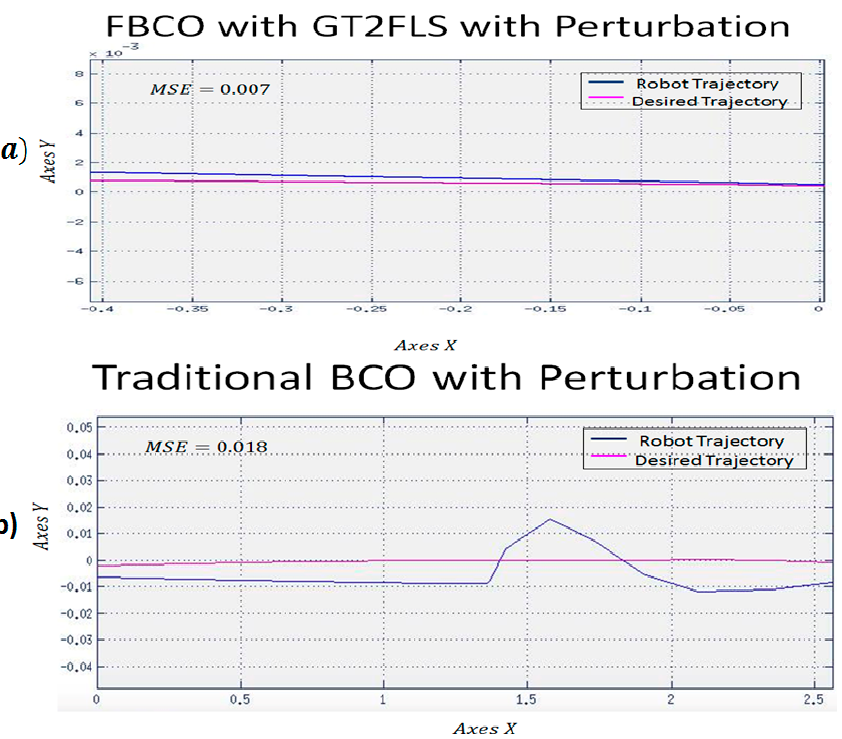
Figure 24. Behavior of the second trajectory for the proposed method applying perturbation in the model. ( a ) FBCO with GT2FLS ( b ) Traditional BCO algorithm.